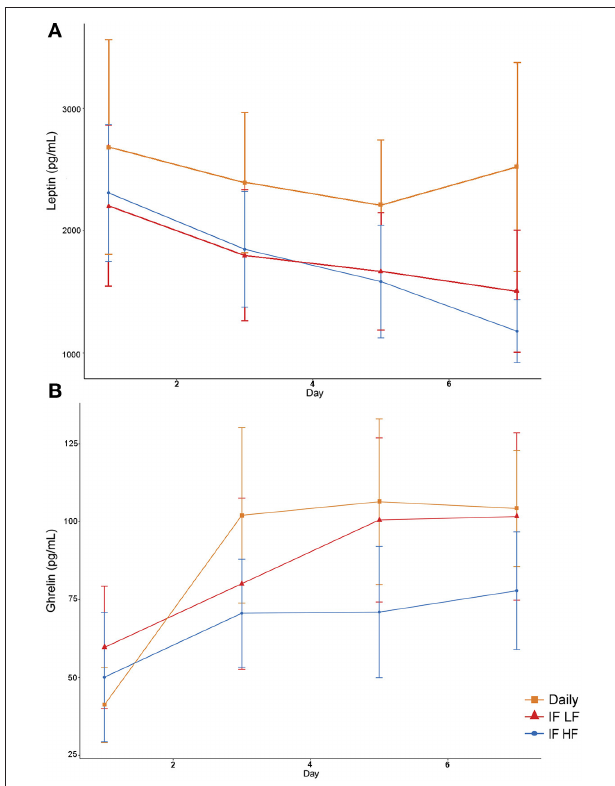
FIGURE 9 | Mean concentrations ( ± SE) of fasted serum leptin (A) and ghrelin (B) in 10 dogs fed daily (square), and intermittently fasted on a low fat (triangle) and a high fat diet (circle) in a Latin Square